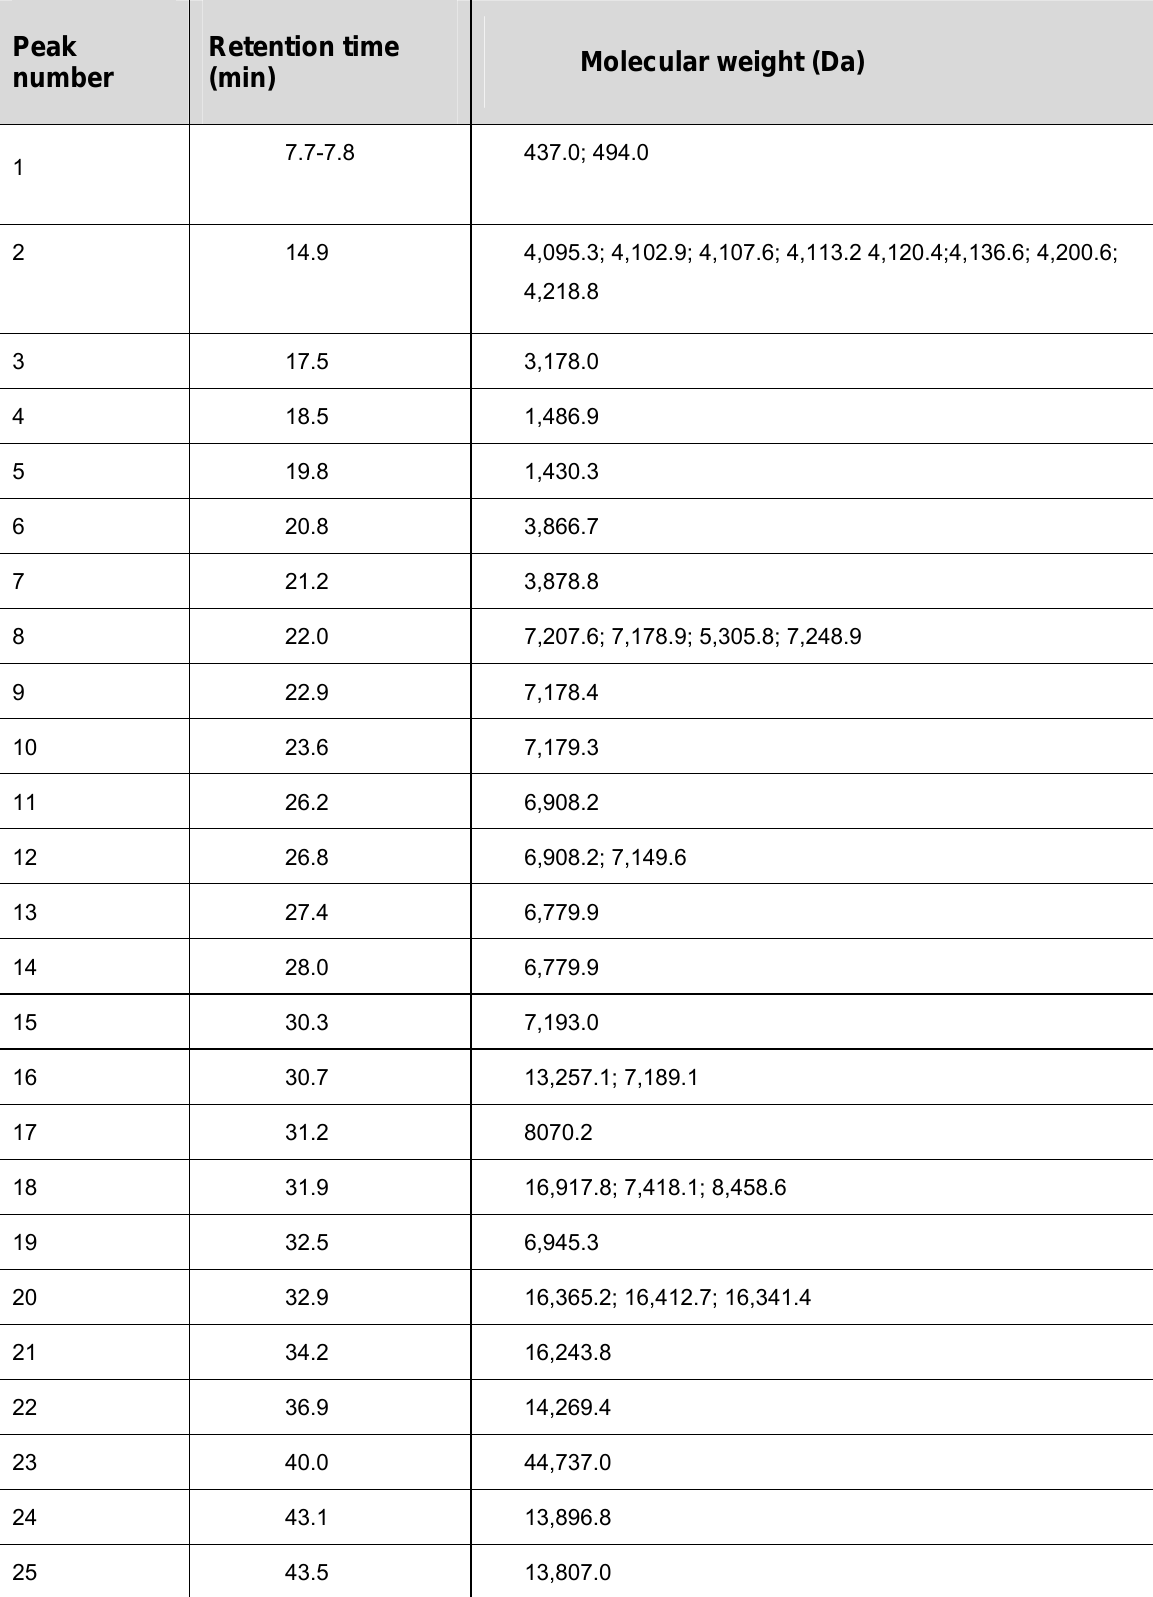
Table 2. Molecular masses of components from A. crassicauda venom